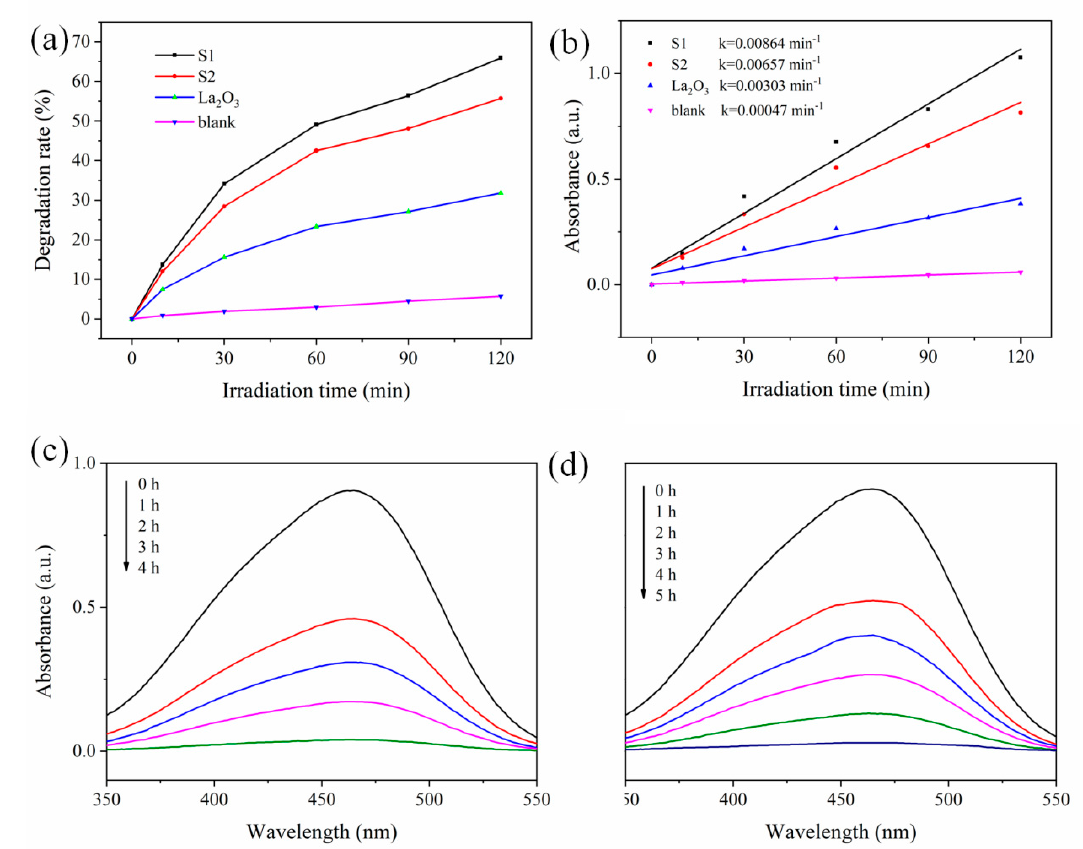
Figure 5. ( a ) Photocatalytic degradation of MO over the samples and ( b ) corresponding pseudo-first-order kinetic plots. The absorbance intensity–wavelength spectra of the variant composites with different times for ( c ) S1 and ( d ) S2.